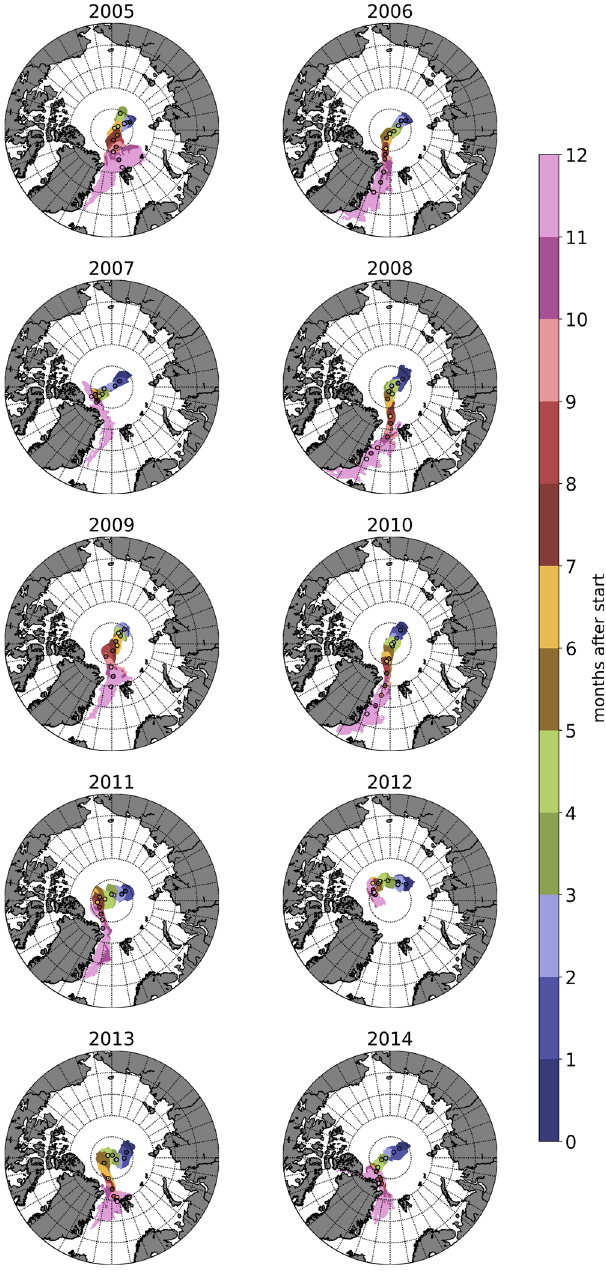
Fig. 2 Ensembles of year-long surface drift in different years. NEMO model-based drift, showing evolution of the ten annual ensembles of 625 surface drift pathways starting at t = t 0 = 6 October in each year, advected for 12 months. Colours represent the elapsed time after the start of the drift and black circles show the ensemble mean position at 0.5, 1.5, … , 11.5